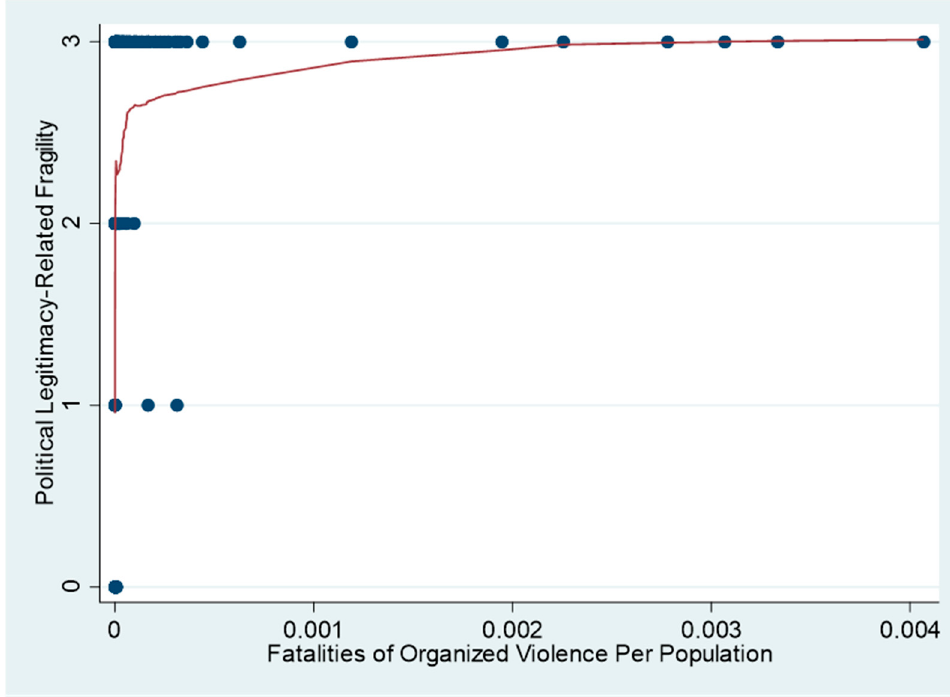
Figure 3. Political Legitimacy Problems and Fatalities of Organized Violence Per Population.